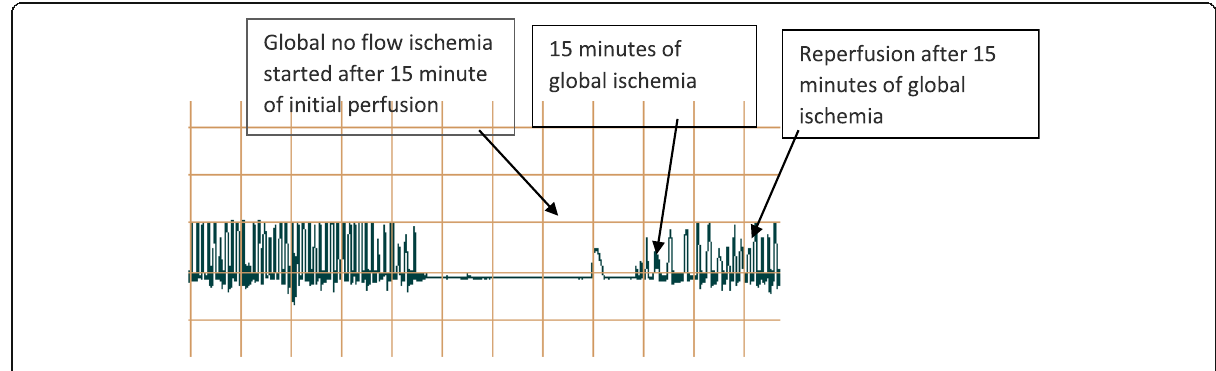
Fig. 6 Tracing on Polygraph of IRI control